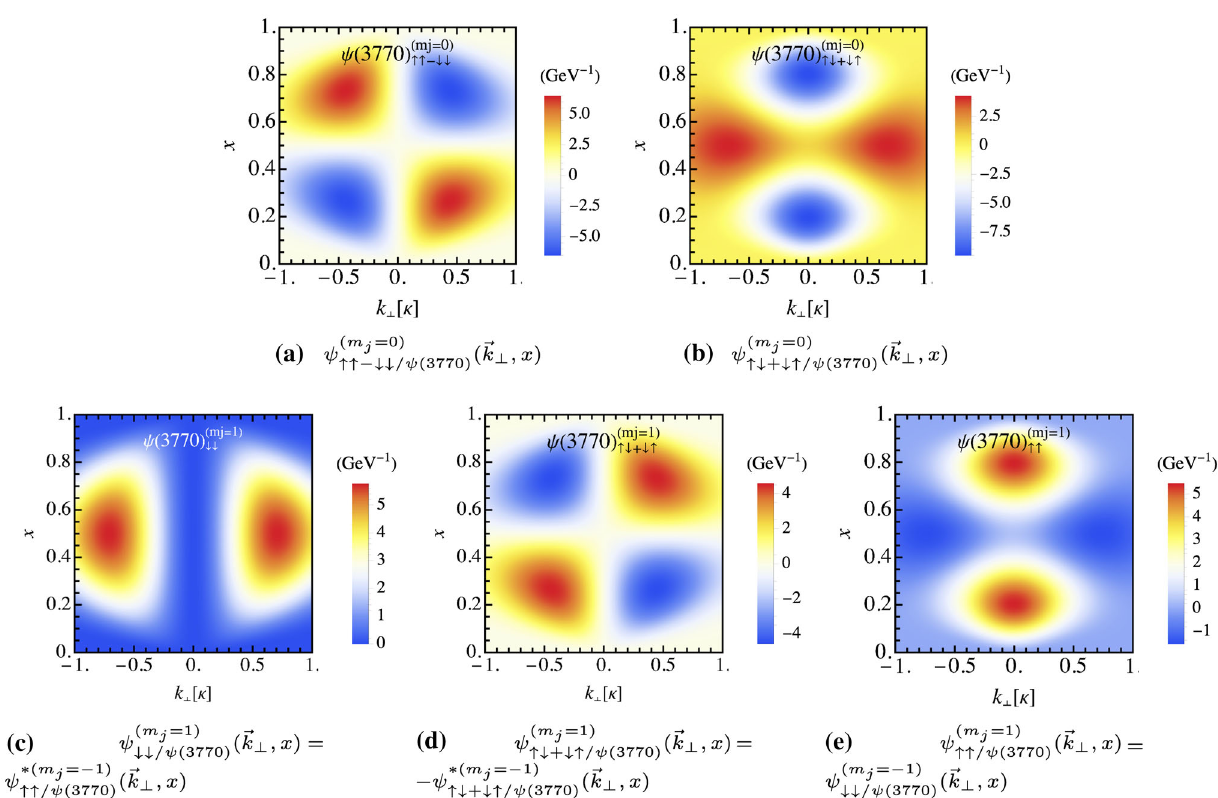
Fig. 10 Plot of the ψ( 3770 ) wavefunction according to Eq. (52) as a function of x and (cid:3) k ⊥ at θ k = 0 ,π , with the basis parameter κ = 1 . 34